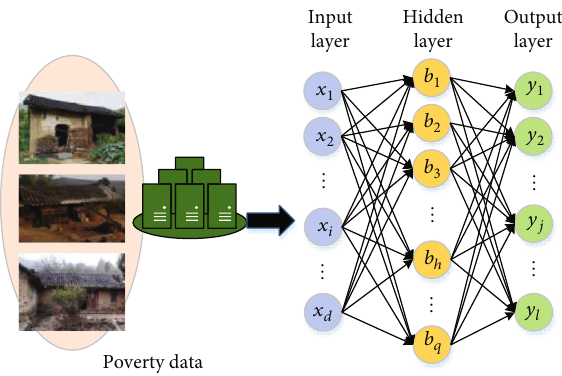
Figure 4: Schematic diagram of BP neural network classi fi cation of relative poverty data visualization